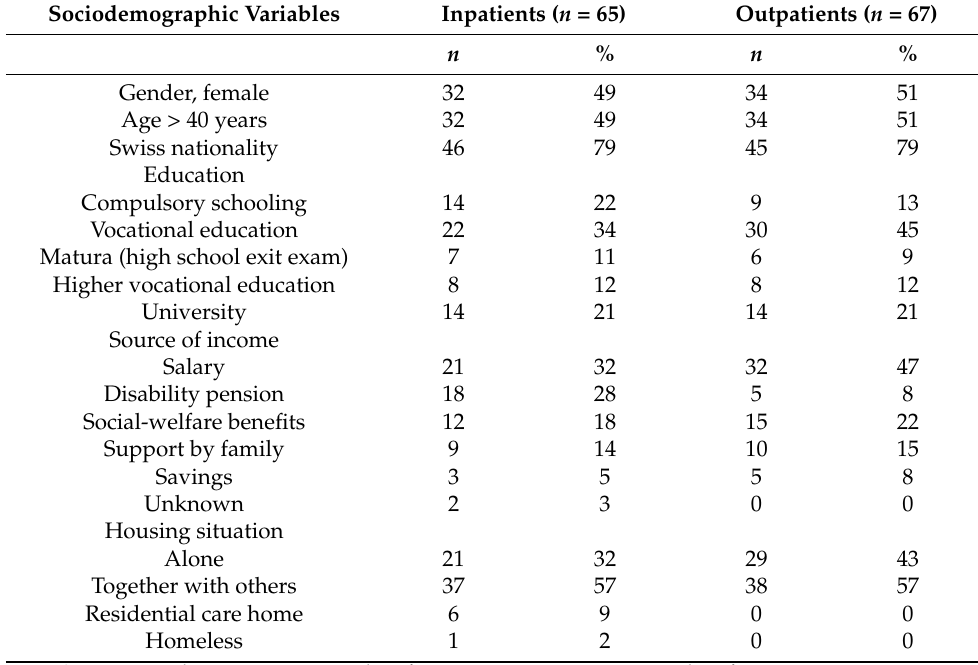
Table 1. Characteristics of the